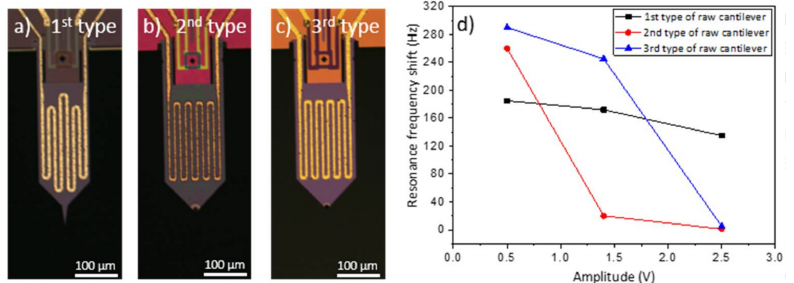
Figure 4. Optical microscopy pictures of the ( a ) first; ( b ) second and ( c ) third type of cantilever used to determine; ( d ) the variation of the resonance frequency shift with the cantilever vibration amplitude. The black, red and blue curves visible on ( d ) correspond to the resonance frequency shift of the first, second and third type of cantilever when 217 ppb of pentaerythritol tetranitrate (PETN) were generated during 3 min in condensation conditions. The vibration amplitude was measured at the maximum of the resonance